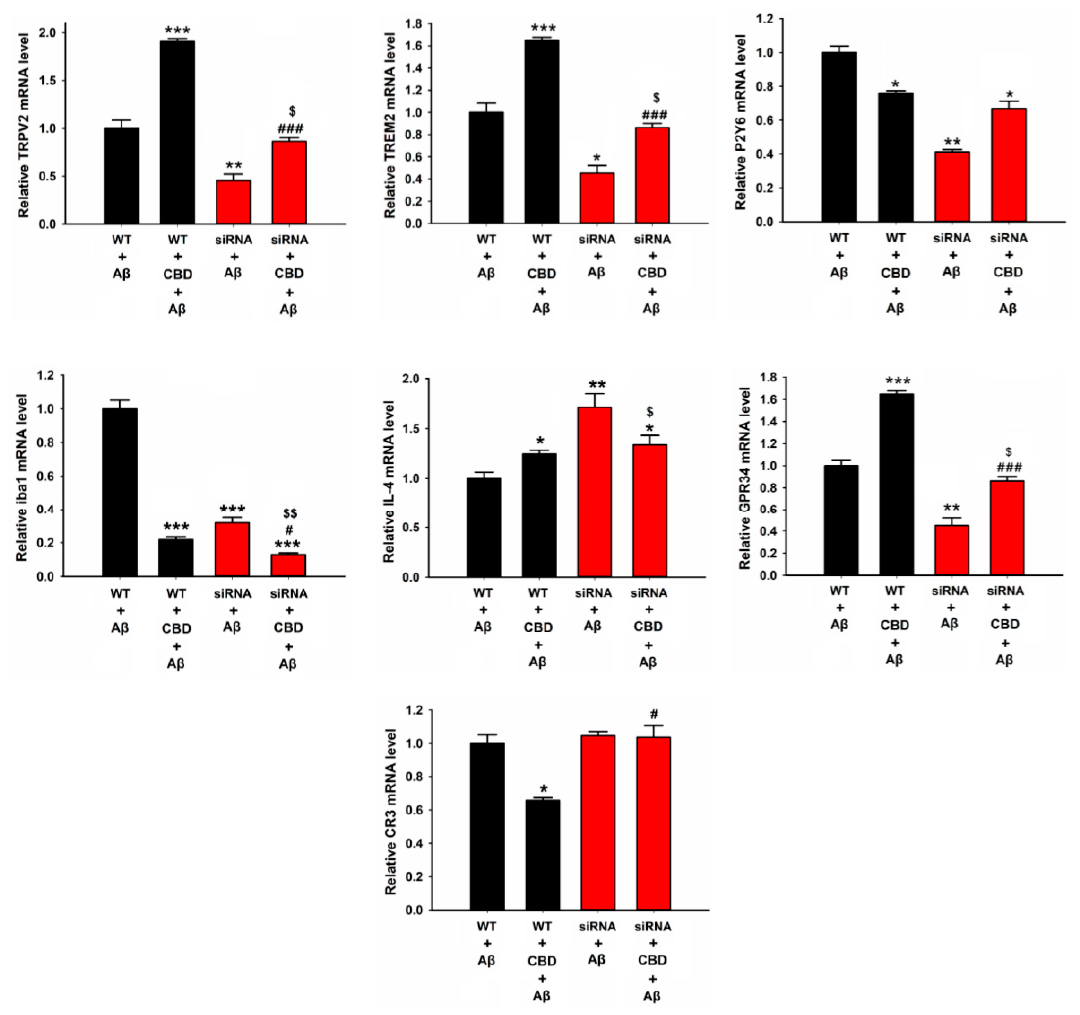
Figure 5. Relative mRNA levels of microglial phagocytic receptors and inflammation factors in microglia cells after knockdown of TRPV2. BV2 microglia were treated with or without CBD (5 μ M) after 12 h, and mRNA levels were determined by qPCR. The data are represented as the mean ± SEM ( n = 4). * p < 0.05, ** p < 0.01, and *** p < 0.001 are compared with wild type treated with A β by Tukey’s test; # p < 0.05 and ### p < 0.001 mean CBD + A β with or without siRNA by Student’s t -test. $ p < 0.05 and $$ p < 0.01 mean CBD knockdown of TRPV2 with or without CBD by Student’s t -test.